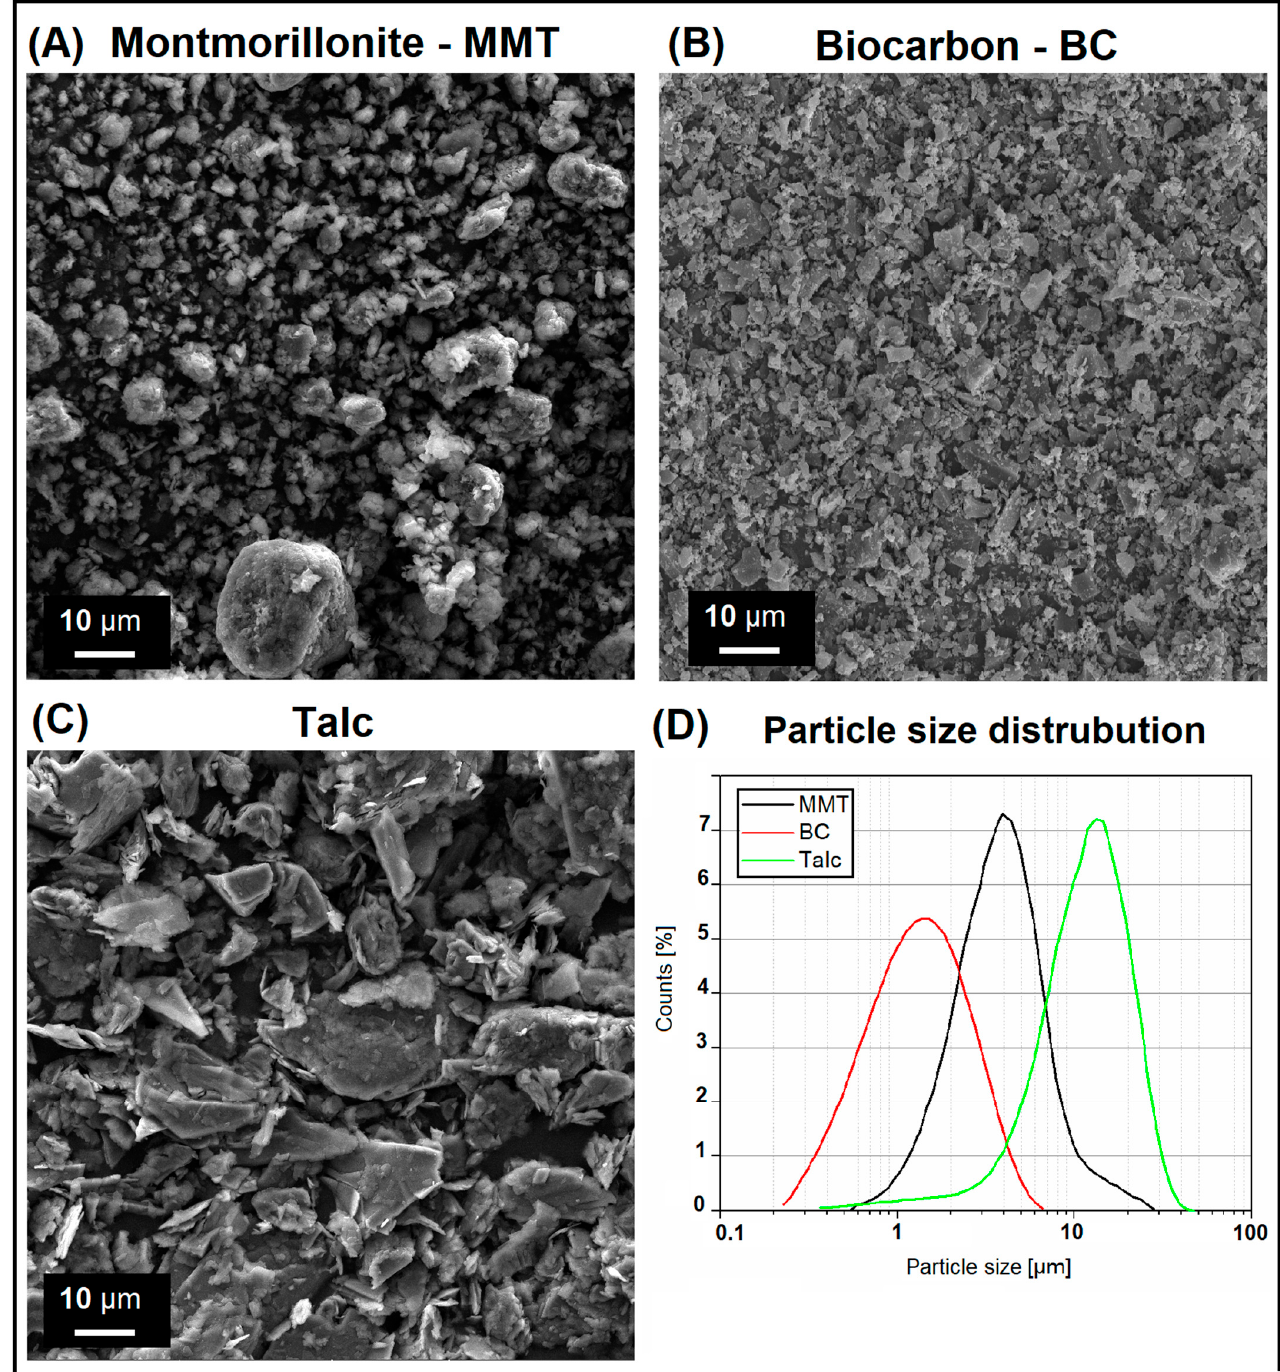
Figure 1. The appearance of ( A ) montmorillonite—MMT, ( B ) biocarbon—BC, and ( C ) talc fillers. ( D ) The size distribution of the presented fillers obtained during SEM pictures analysis.